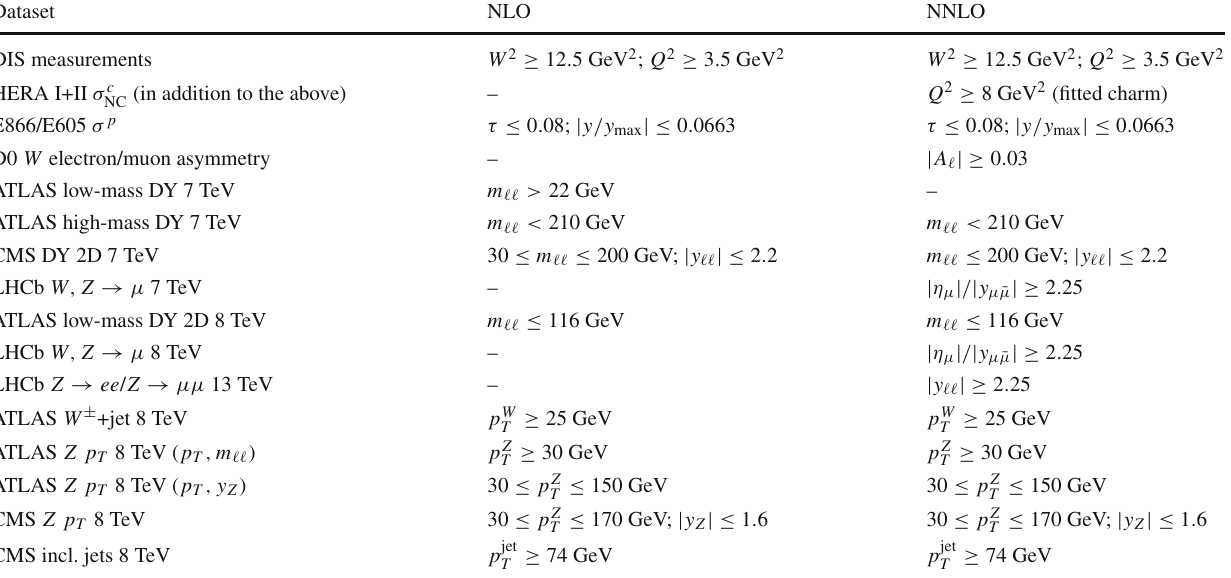
Table 11 The set of kinematic cuts applied to the datasets considered in the NNPDF4.0 PDF determination for the NLO and NNLO fits. The kinematic cuts used in the LO fit are the same as in the NLO fit. Only the data points that satisfy the constraints listed in the table are retained.